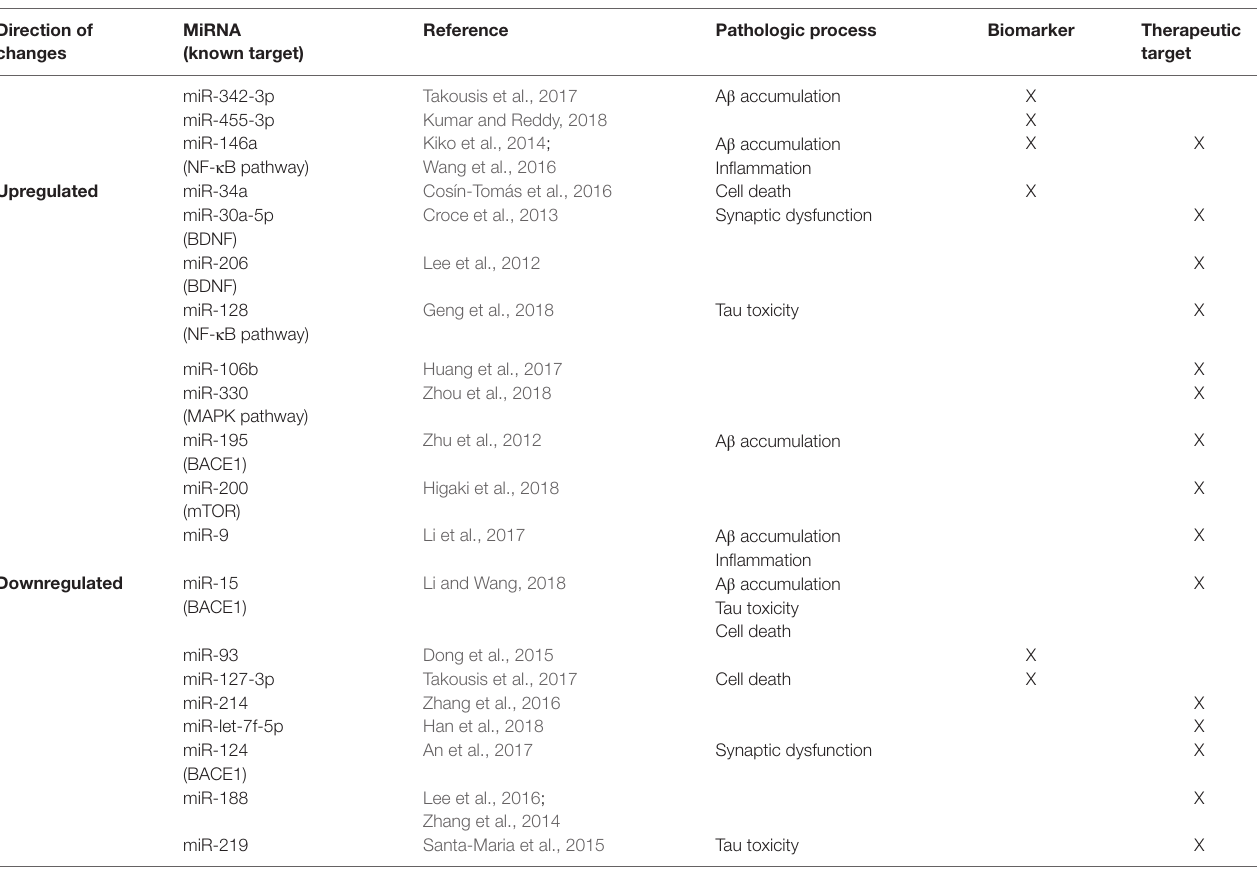
TABLE 1 | Most recent MiRNAs associated with AD pathophysiological